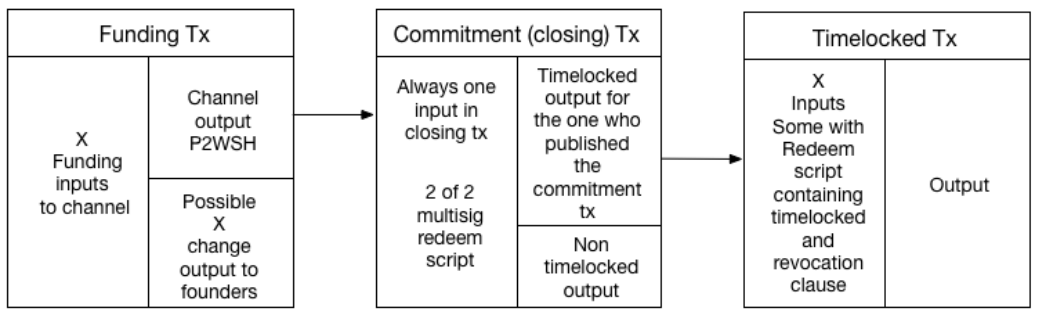
Figure 6. Channel graph of unilaterally closed channel.